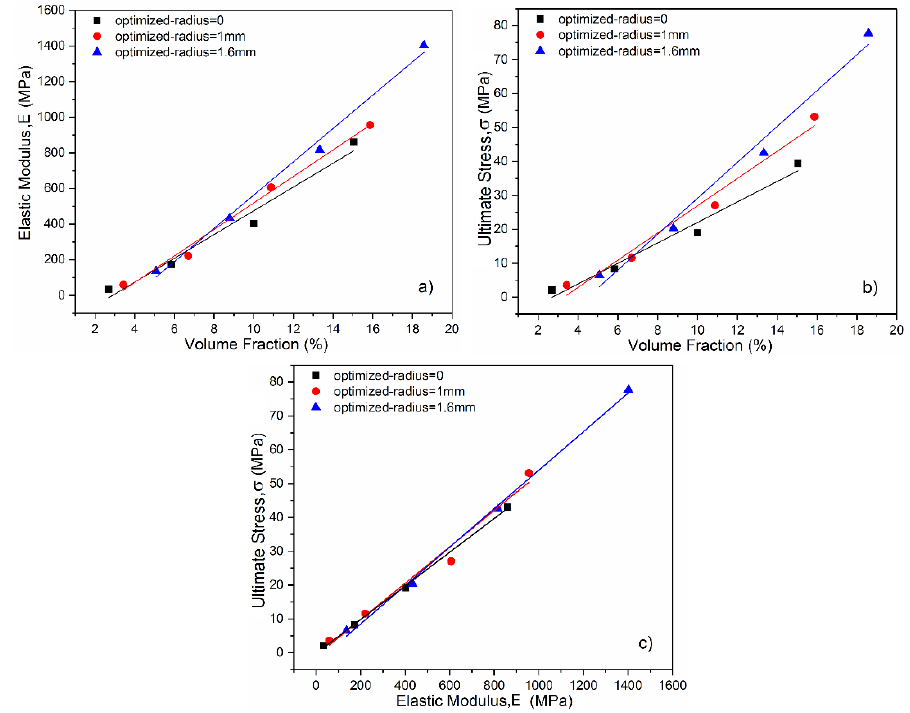
Figure 8. Mechanical properties of the diamond structures with different optimized-radius: ( a ) Elastic modulus; ( b ) ultimate stress; ( c ) the relationship between elastic modulus and compression strength.